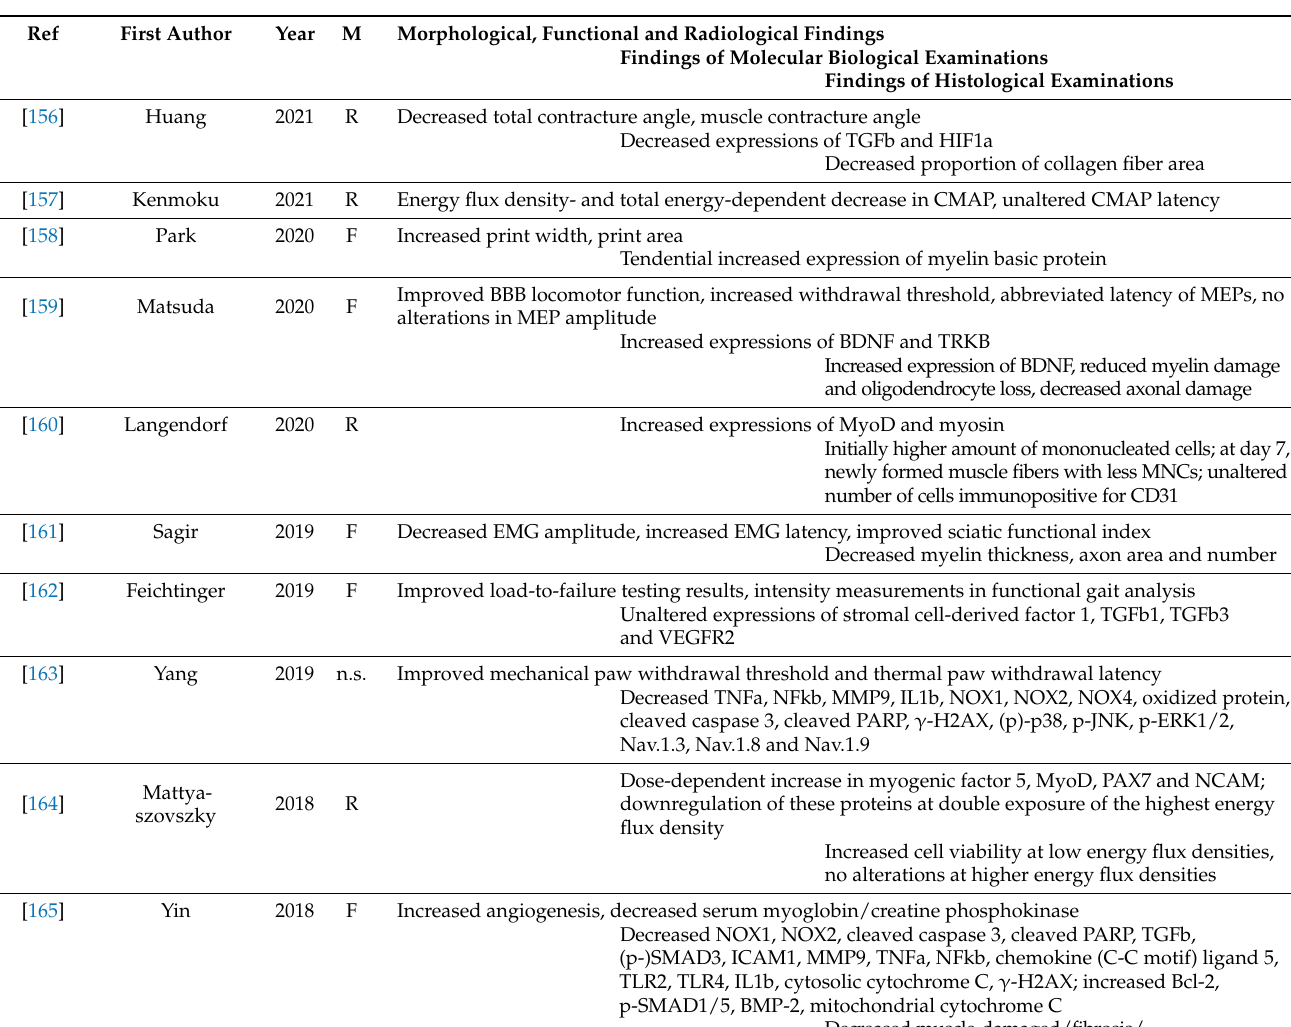
Table 3. Effects of the exposure of muscle and nerve tissue to extracorporeal shock waves (more details of the studies listed in this table are provided in Table